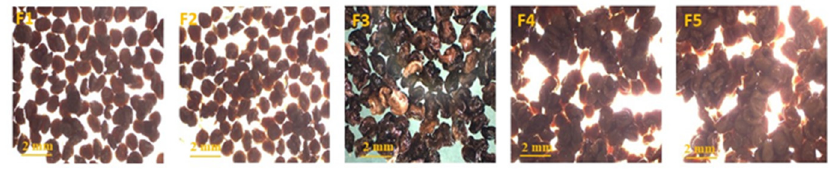
Figure 1. The microscopic images of coated pectin beads F1–F5.